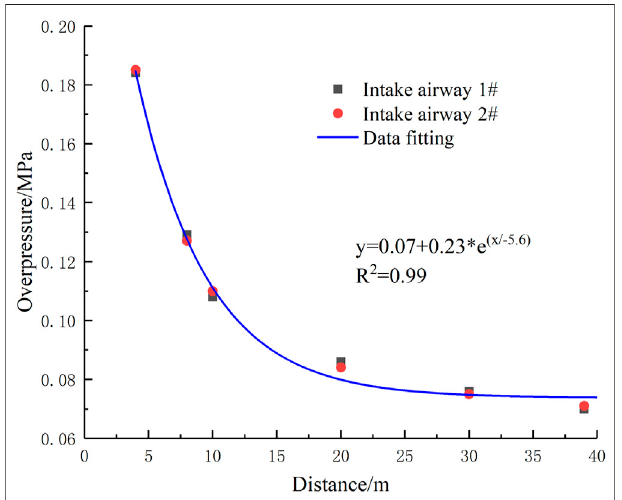
FIGURE12 | Variation ofthe peak value ofoverpressure with distancein intake airways 1 and 2.